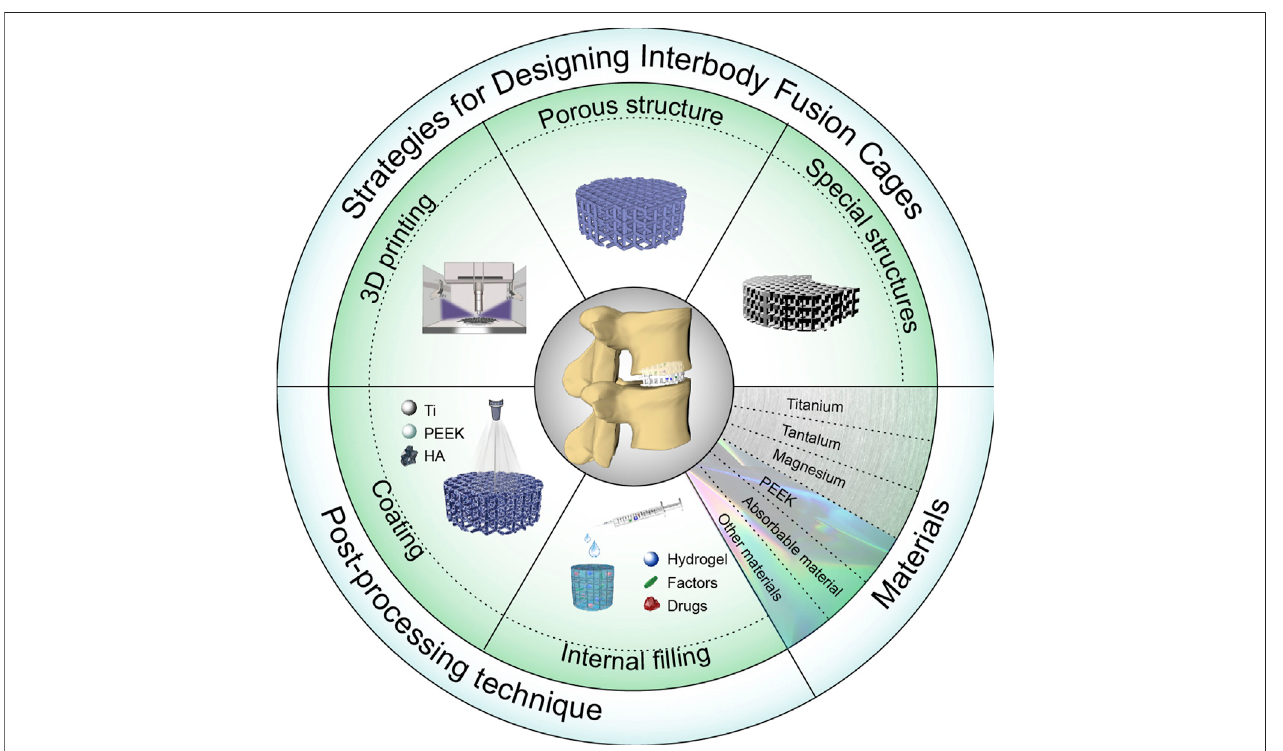
SCHEME 1 | Schematic diagram of an interbody fusion cage. Design and application of the interbody cage.